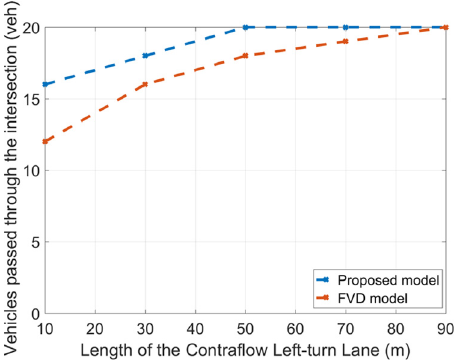
Figure 5 Effect of length of the contra fl ow left-turn